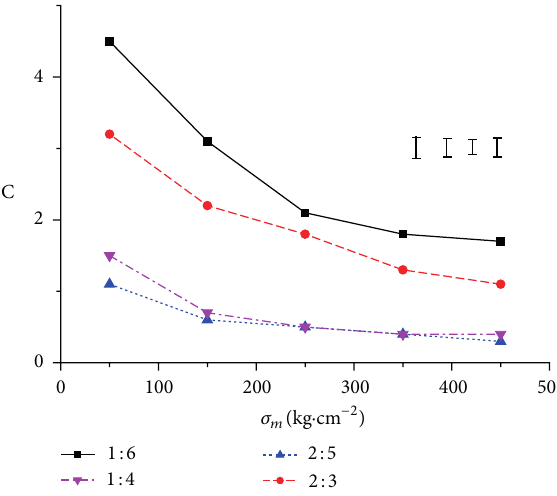
Figure 2: Impact of plasticizer content on the cushion coefficient- maximum stress (C- 𝜎 𝑚 ) curve. Bars indicate mean ± average stan- dard deviation.